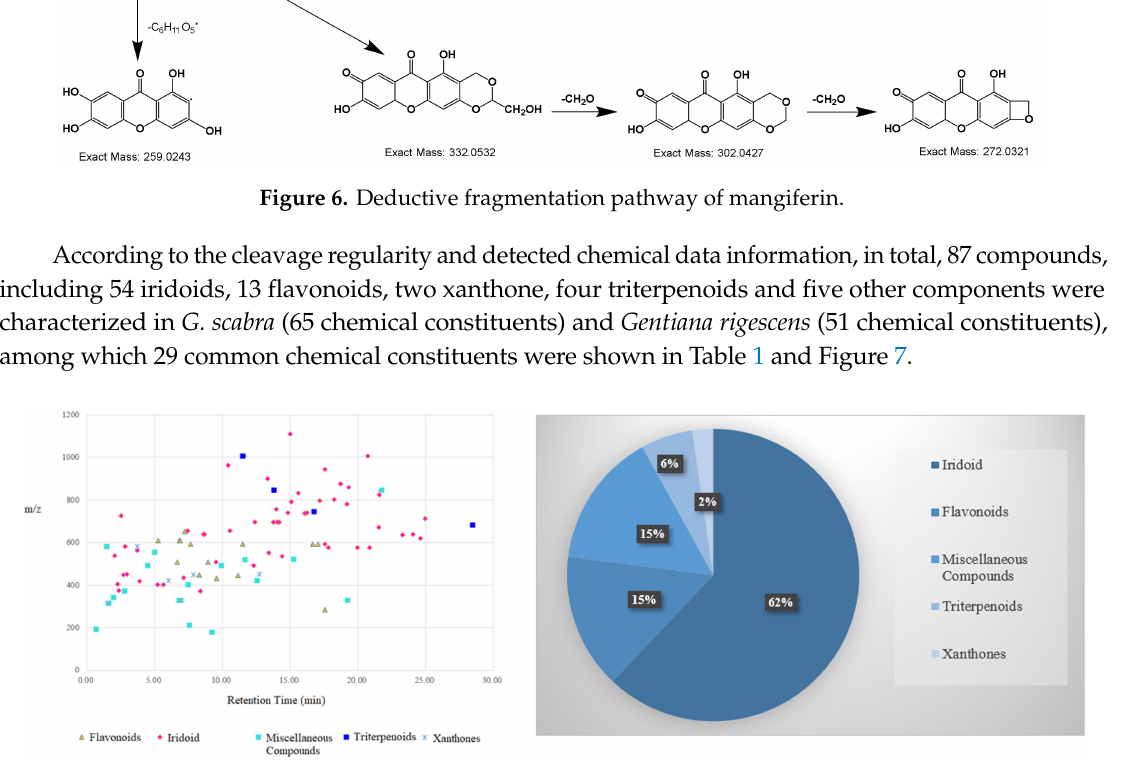
Figure 7. Characterization of chemical constituents of two species of GRR by UHPLC -LTQ-Orbitrap / MS in negative ion